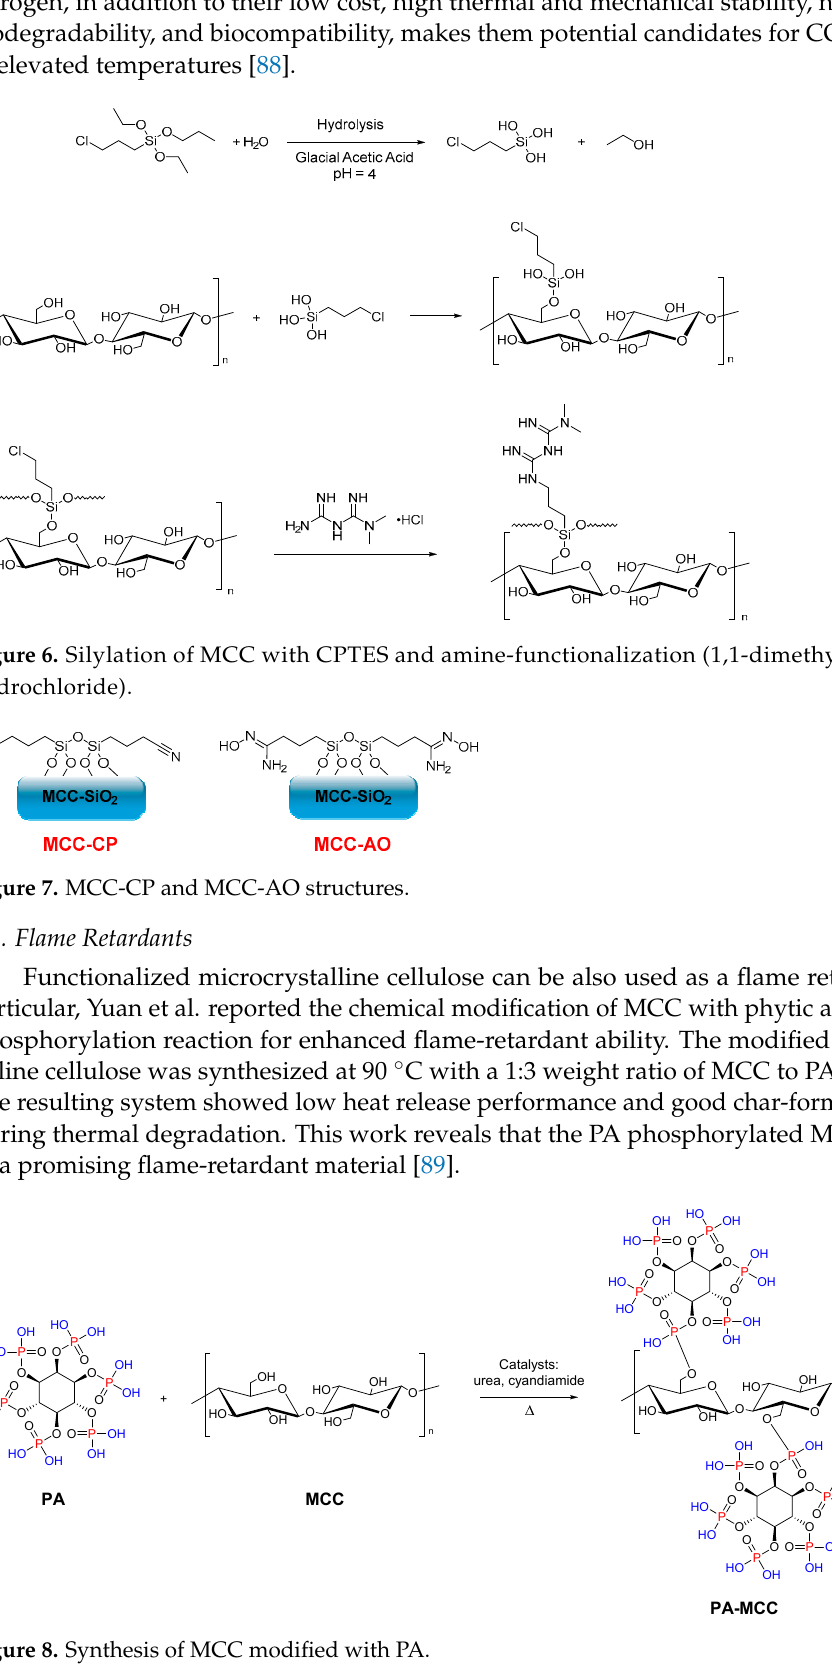
Figure 6. Silylation of MCC with CPTES and amine-functionalization (1,1-dimethylbiguanide hy- drochloride).